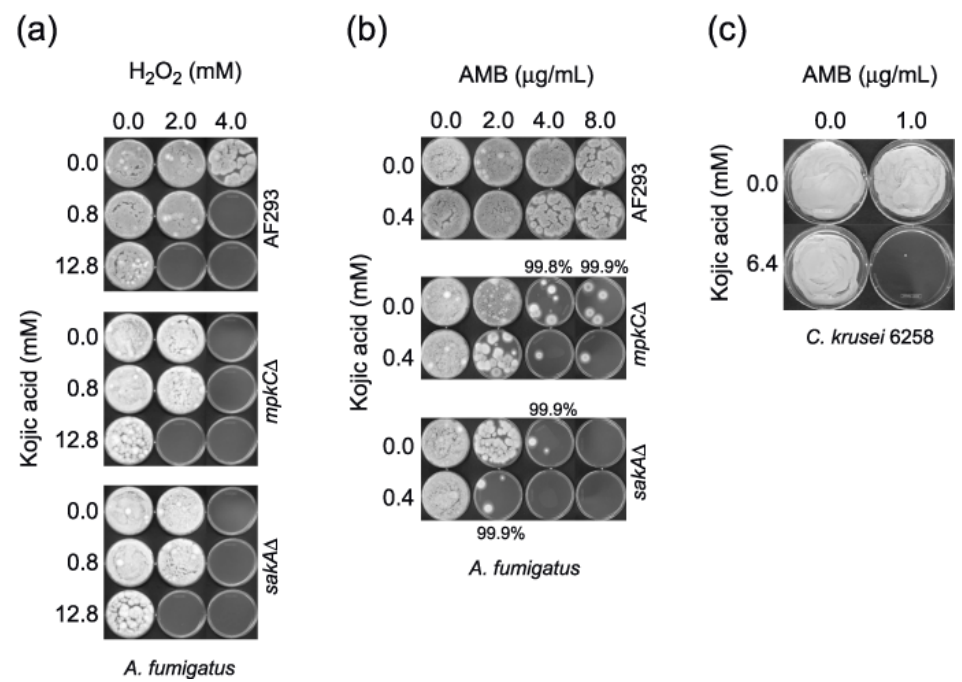
Figure 3. ( a ) MFC determination of A. fumigatus strains (AF293, sakA ∆ , mpkC ∆ ) with the treatment of kojic acid (KA) + H O . ( b ) MFC determination in A. fumigatus sakA ∆ strain 2 2 with the treatment of KA + AMB. Results indicated that A. fumigatus AF293 and mpkC ∆ strains needed higher concentration of KA or AMB to achieve ≥ 99.9% cell death compared to sakA ∆ . ( c ) MFC determination in Candida krusei ATCC6258 with the treatment of KA +